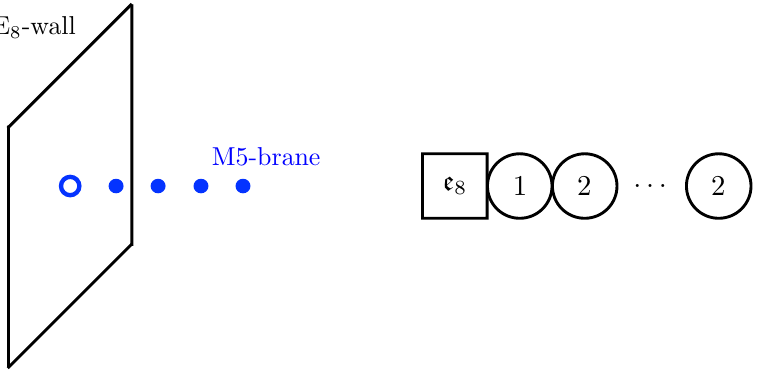
Figure 1 . M-theory setup for a higher-rank E-string theory and its F-theory geometry.